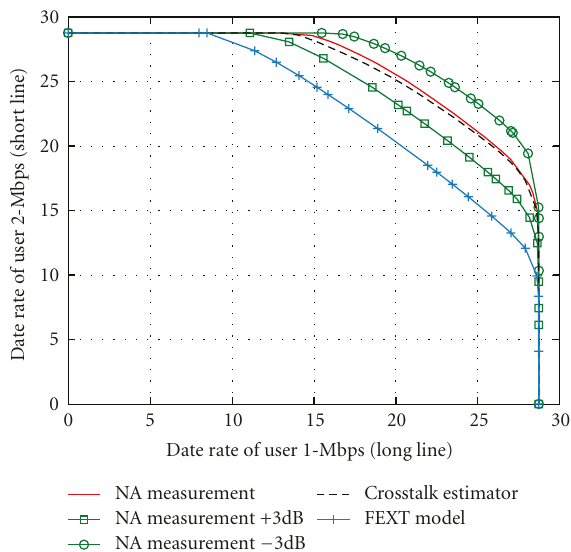
Figure 10: Simulation results obtained with the SCALE algorithm.